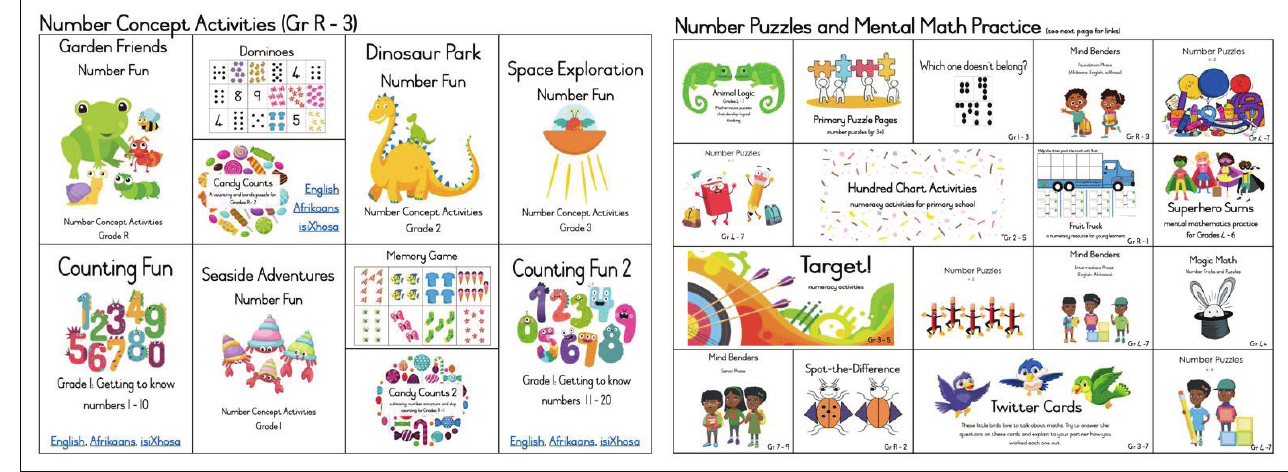
FIGURE 2: Front covers of a range of the resources developed and